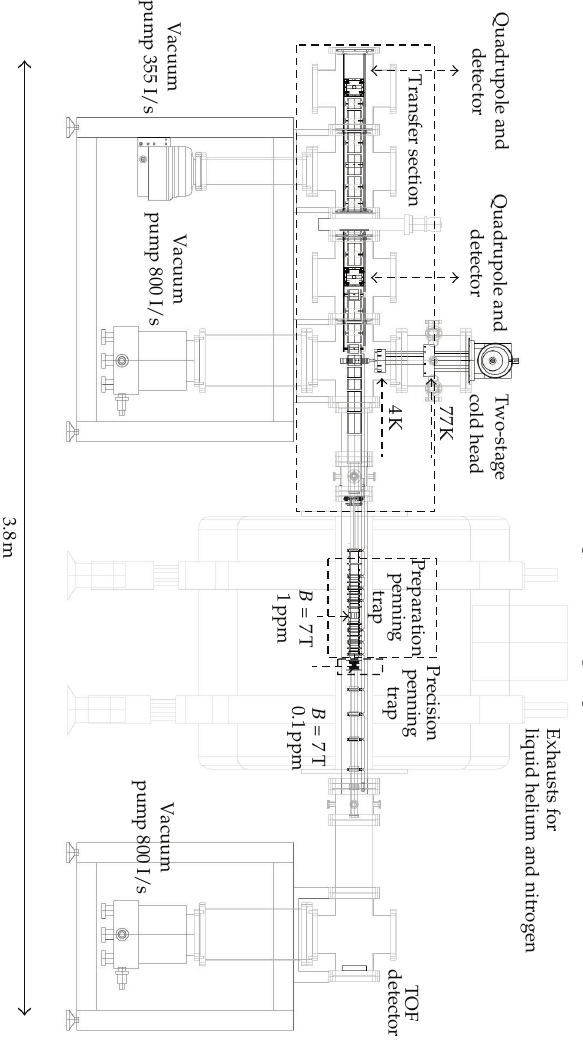
Figure 6: Layout of the Penning-trap beamline to perform high-precision mass measurements. The beamline will be coupled to an existing laser-desorption ion